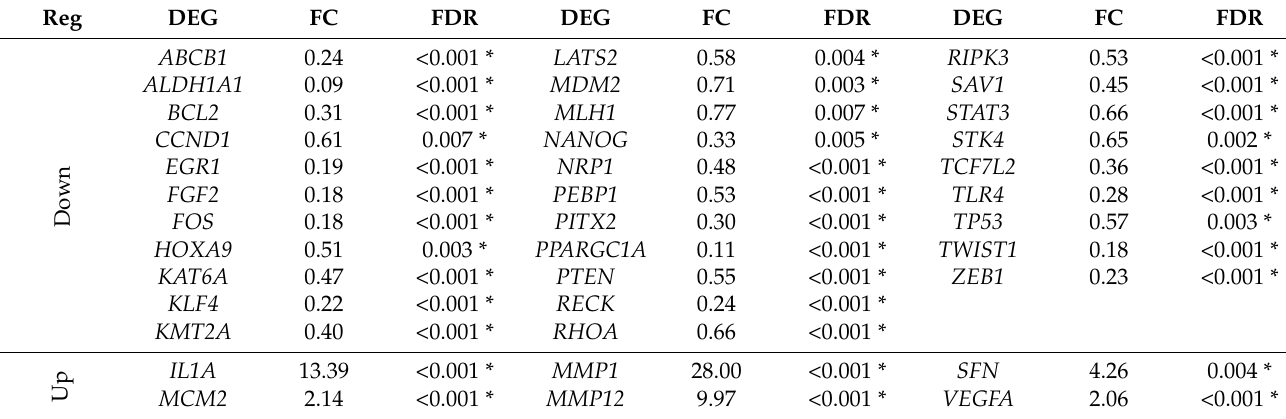
Table 4. DEGs detected in the comparison of tumor tissues ( n = 24) and non-neoplastic tissues ( n = 24) of PeC patients by qRT-PCR.